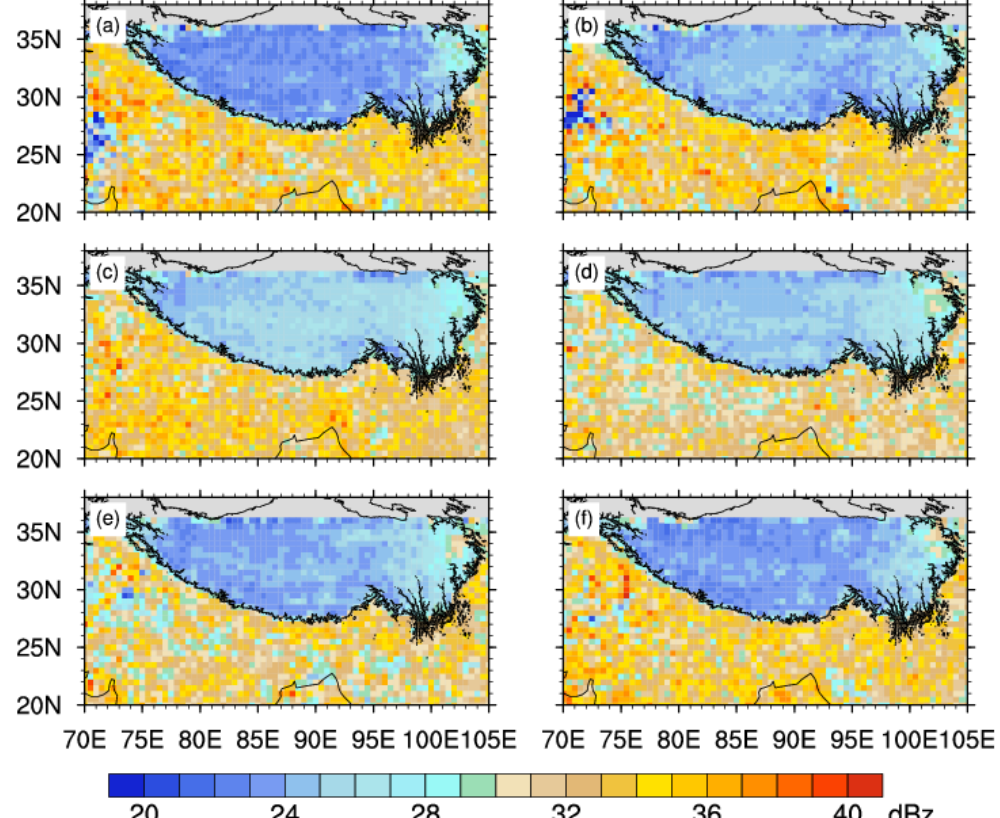
Figure 10. The distribution of the maximum echo for DCP in ( a ) early morning, ( b ) forenoon, ( c ) noon, ( d ) afternoon, ( e ) evening, and ( f ) midnight in summer over the QTP and its southern regions calculated from observations of TRMM PR from 1998 to 2012. Note: This is the same as in Figure